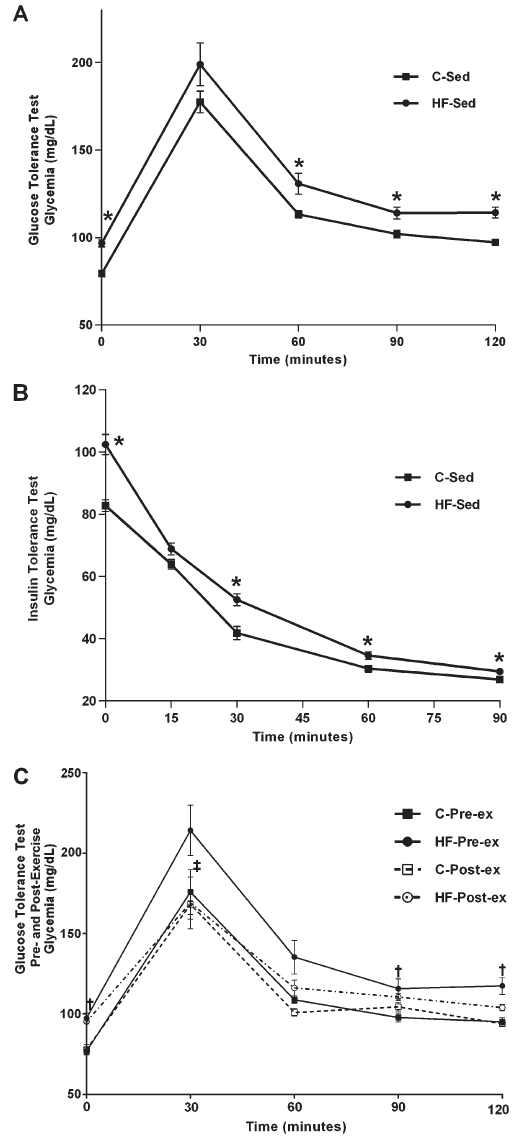
Figure 2. Glucose and insulin tolerance tests. Analysis of glycemia profile by the A , glucose tolerance test (GTT) and the B , insulin tolerance test (ITT) at the end of the 12th week in rats fed a high-fat diet. C , Analysis of glycemia profile by the GTT pre-exercise (12th week) and post-exercise (16th week) training. Data are reported as means±SE for n=15 (C and HF groups) and n=6-7 rats/subgroup. *P , 0.05, high-fat diet group (HF) vs control group (C). { P , 0.05, exercised high-fat diet group pre- exercise (HF-Pre-ex) vs exercised control group pre-exercise (C-Pre-ex); { P , 0.05, HF-Pre-ex vs exercised high-fat diet group post-exercise (HF-Post-ex) ( t control rats after 12 weeks of the diet regimen (Figure 2A and B). The post-exercise glycemic response to glucose injection was significantly lower than the pre-exercise test